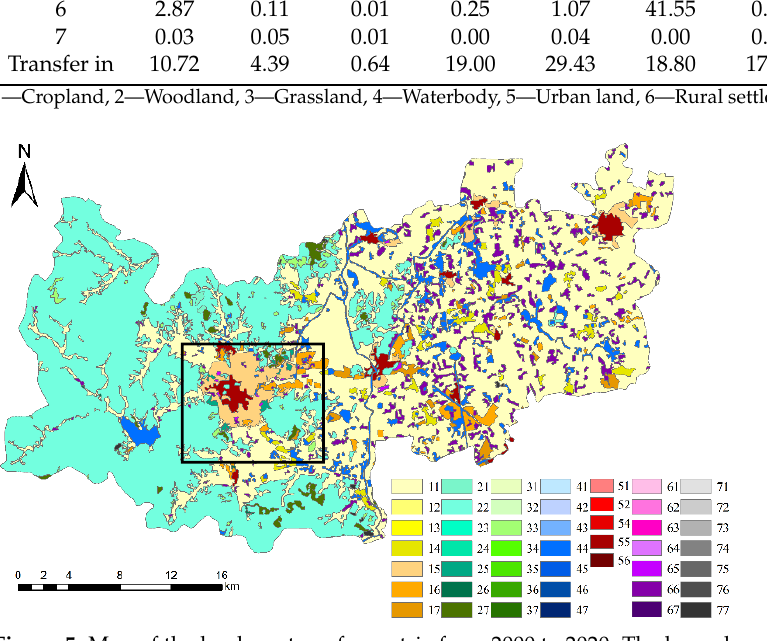
Figure 5. Map of the land use transfer matrix from 2000 to 2020. The legend explains changes in land use; for example, since 1—Cropland and 6—Rural settlements, 16 represents the cropland that is converted to rural settlements.